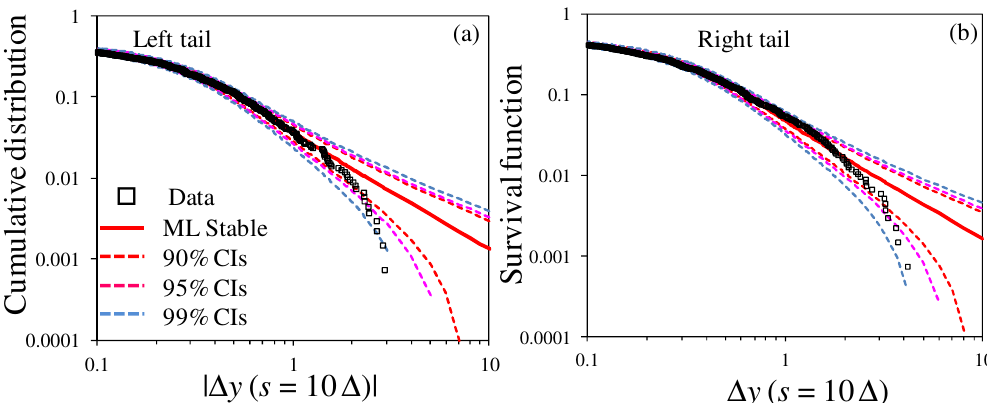
Fig. 14. Tails of (a) cumulative distribution versus | 1y | for 1y < 0 and (b) survival function versus 1y for 1y > 0 of increments evaluated along x direction on Berea sandstone block at s = 10 1 . Solid curves represent ML fitted stable distribution; dashed curves indicate CIs.